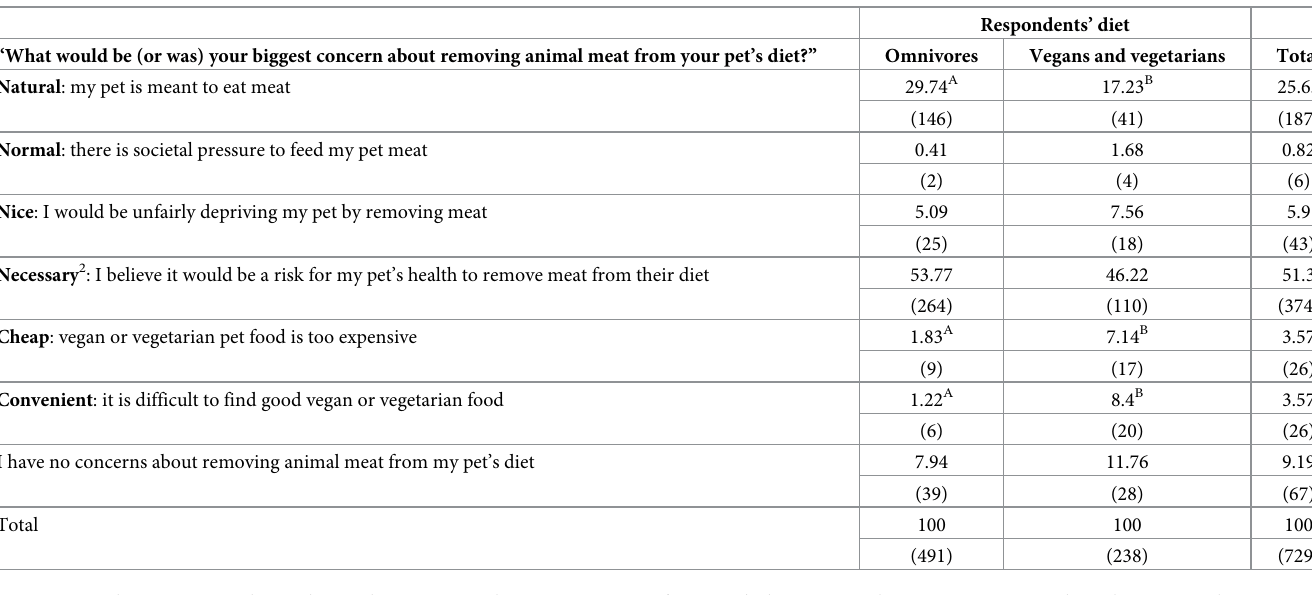
Table 4. Primary concern about removing meat from pet’s diet, by respondents’ diet.